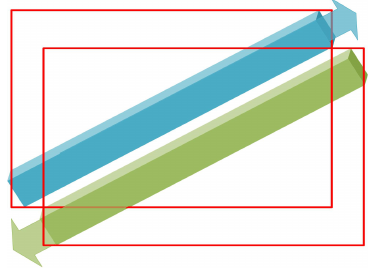
Figure 2. Two objects in opposite directions are prone to loss in NMS